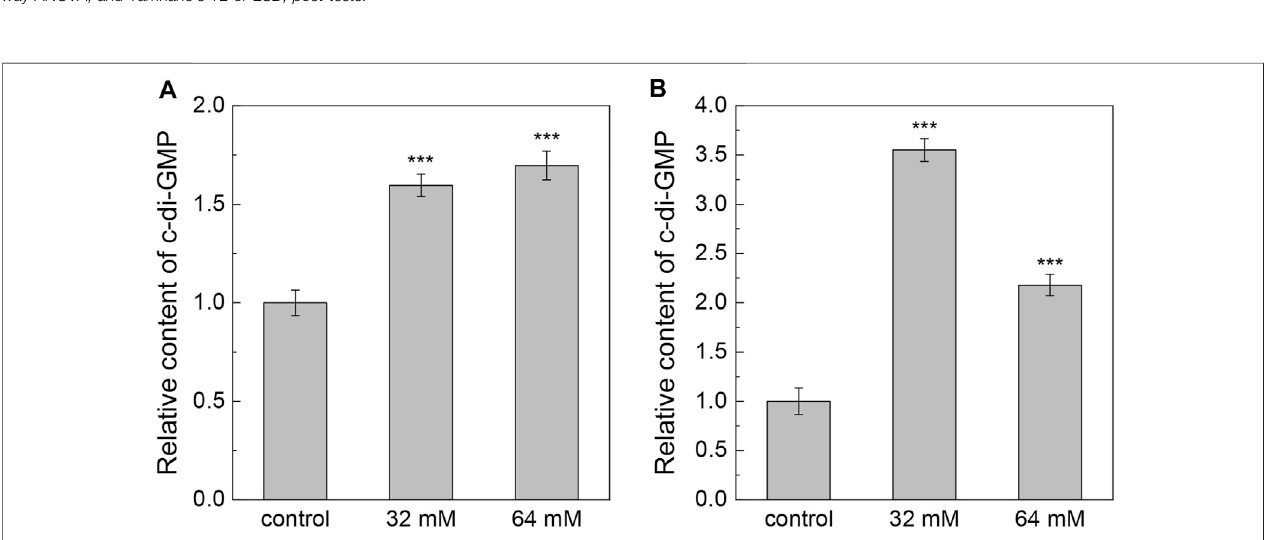
FIGURE 7 | Effects of adding CaCl 2 on the relative content of intracellular c-di-GMP of Pseudomonas sp. ZX01 (A) and Arthrobacter sp. ZX07 (B) . Bars represented mean ±standard deviation ofthree replicates. Symbols (***) labeled on thebars represented thesigni fi cantdifference ( p < 0.001)withthecontrolaccording to Student ’ s t